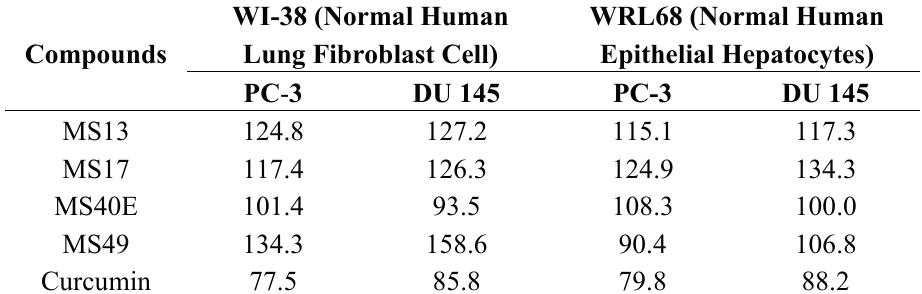
Table 2. Selective index ( SX ) values of compounds on each tested prostate cancer cell lines and normal cell